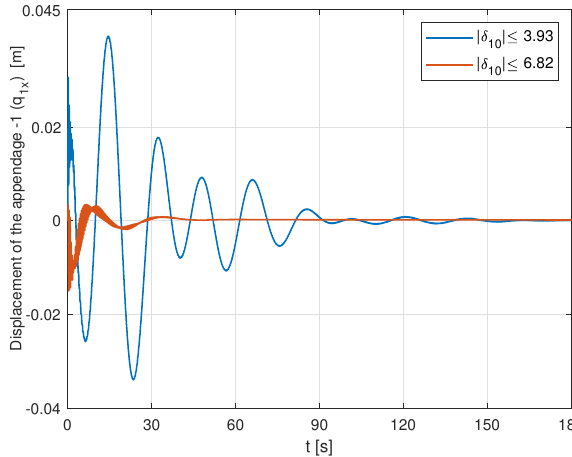
Figure 21. Displacement of appendage 1.